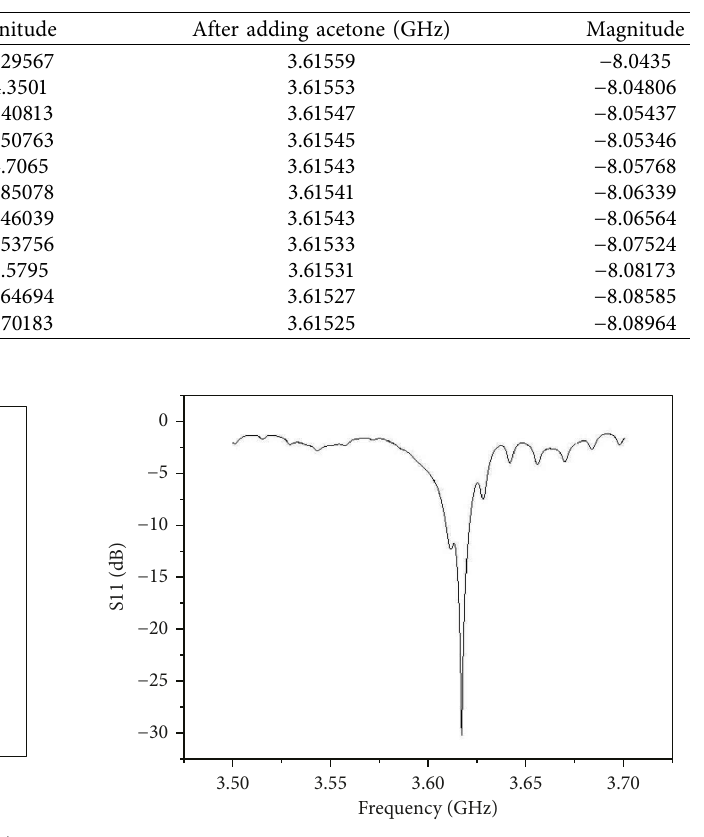
Table 4: Te resonance frequency comparison of before and after adding acetone solutions.